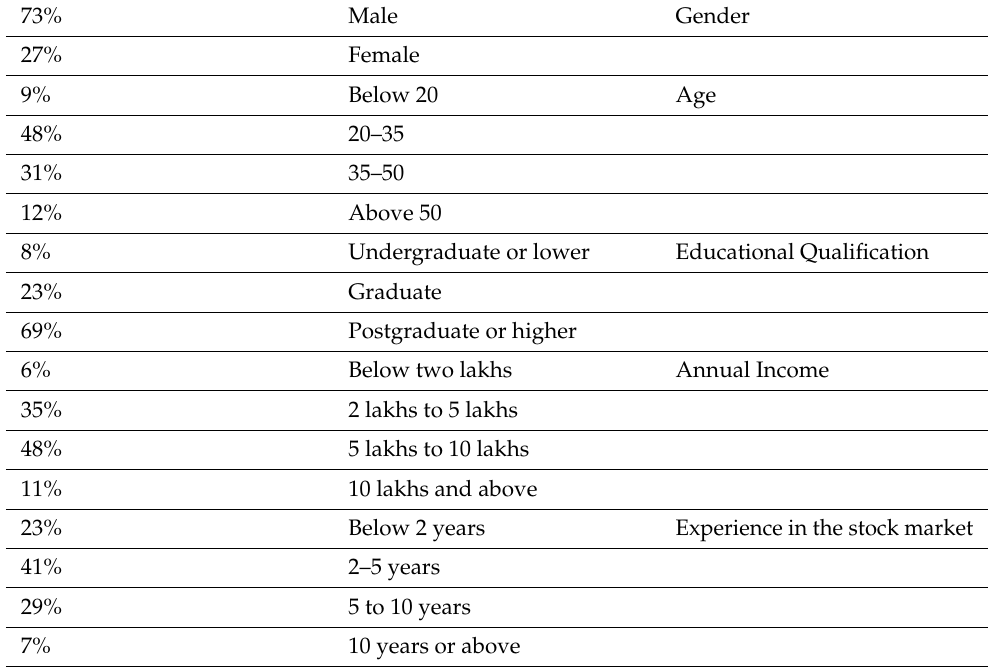
Table 2. Demographic profile of respondents.